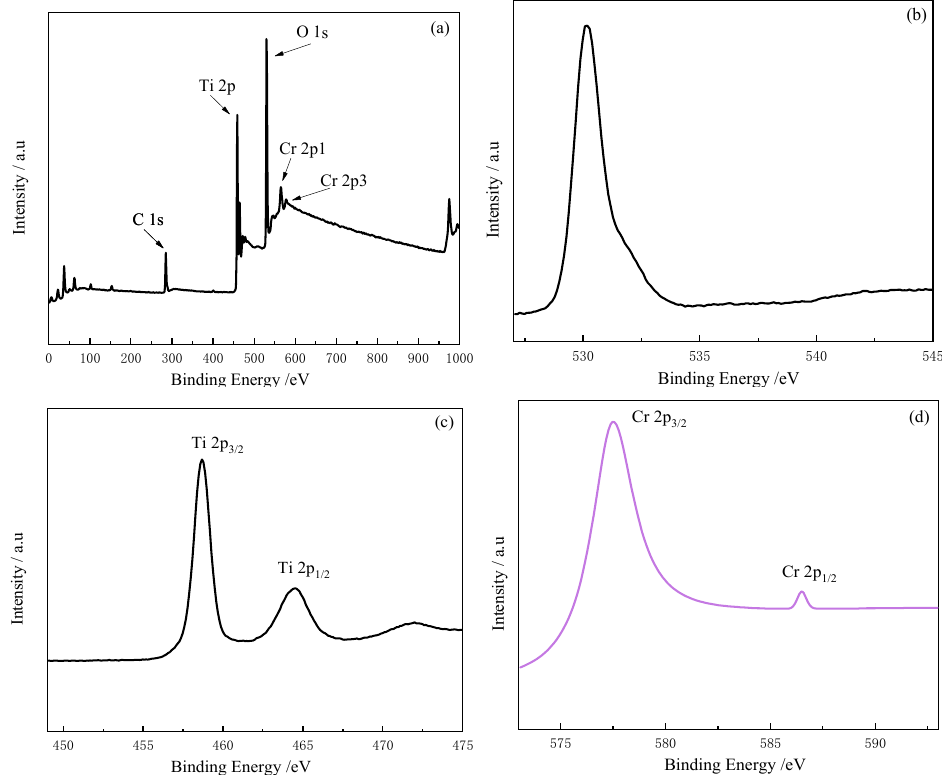
Figure 6. XPS spectra: survey for ( a ) Cr-TiO 2 ; ( b ) O 1s; ( c ) Ti 2p; and ( d ) Cr 2p.